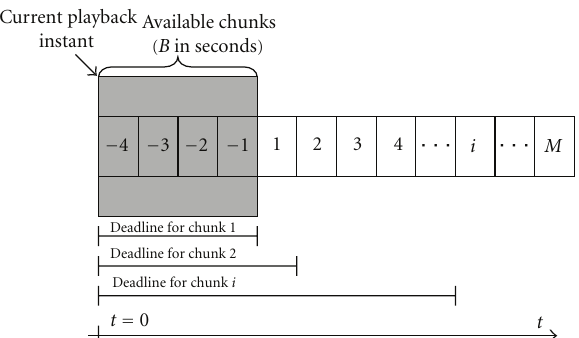
Figure 2: Playback bu ff er, video chunks, and associated deadlines.